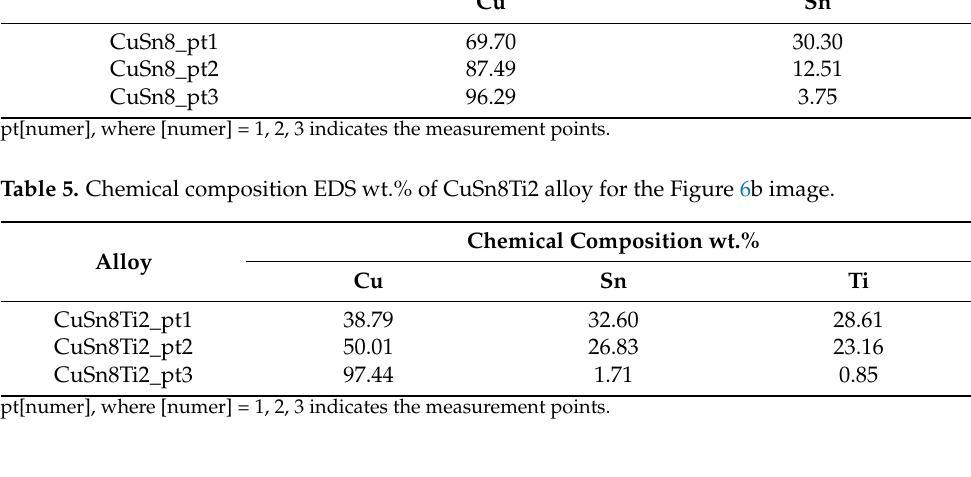
Figure 8. Powder diffraction spectrum of the CuSn8Ti2 alloy.